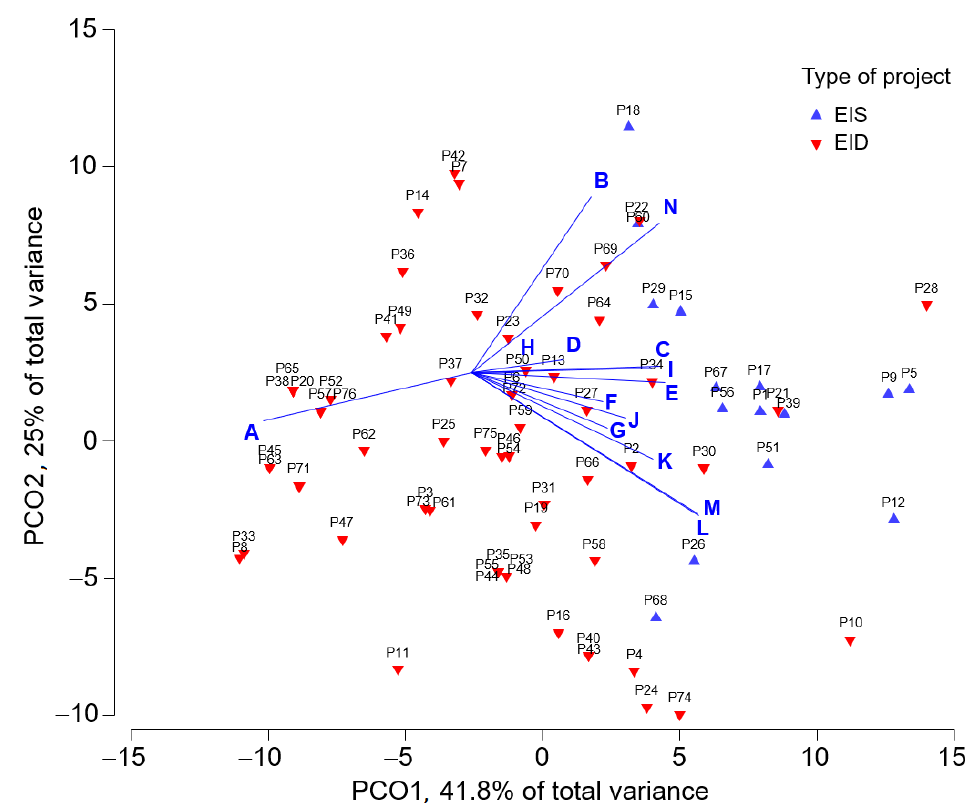
Figure 5. First factorial plane coordinates PCO1 and PCO2 of the PCoA performed on the 76 selected (sample) sanitation projects (15 entered as EIS and 61 as EID). Codes “ A ” throughout “ N ” identify the 14 selected indicators included in Table 2. Full information of selected sanitation projects is available in Table A1 in Appendix A.